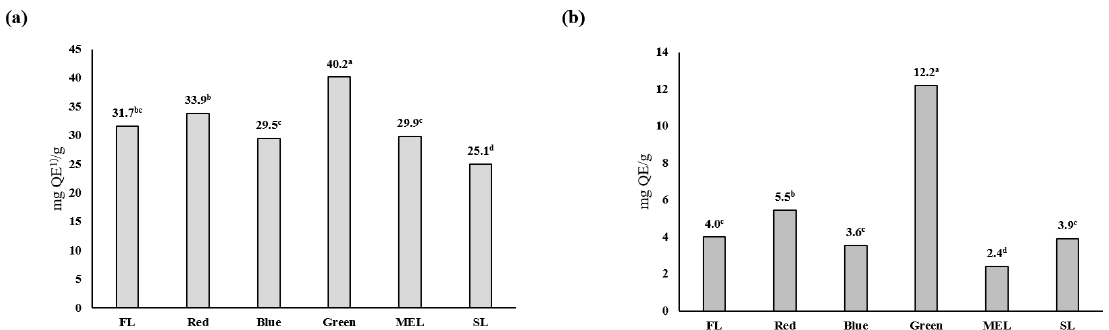
Figure 4. Total flavonoid contents of aerial ( a ) and underground ( b ) parts from extracts of Dachul under different light sources. (1) QE; quercetin equivalents. Values represent mean of data obtained from three independent experiments ( p < 0.05).